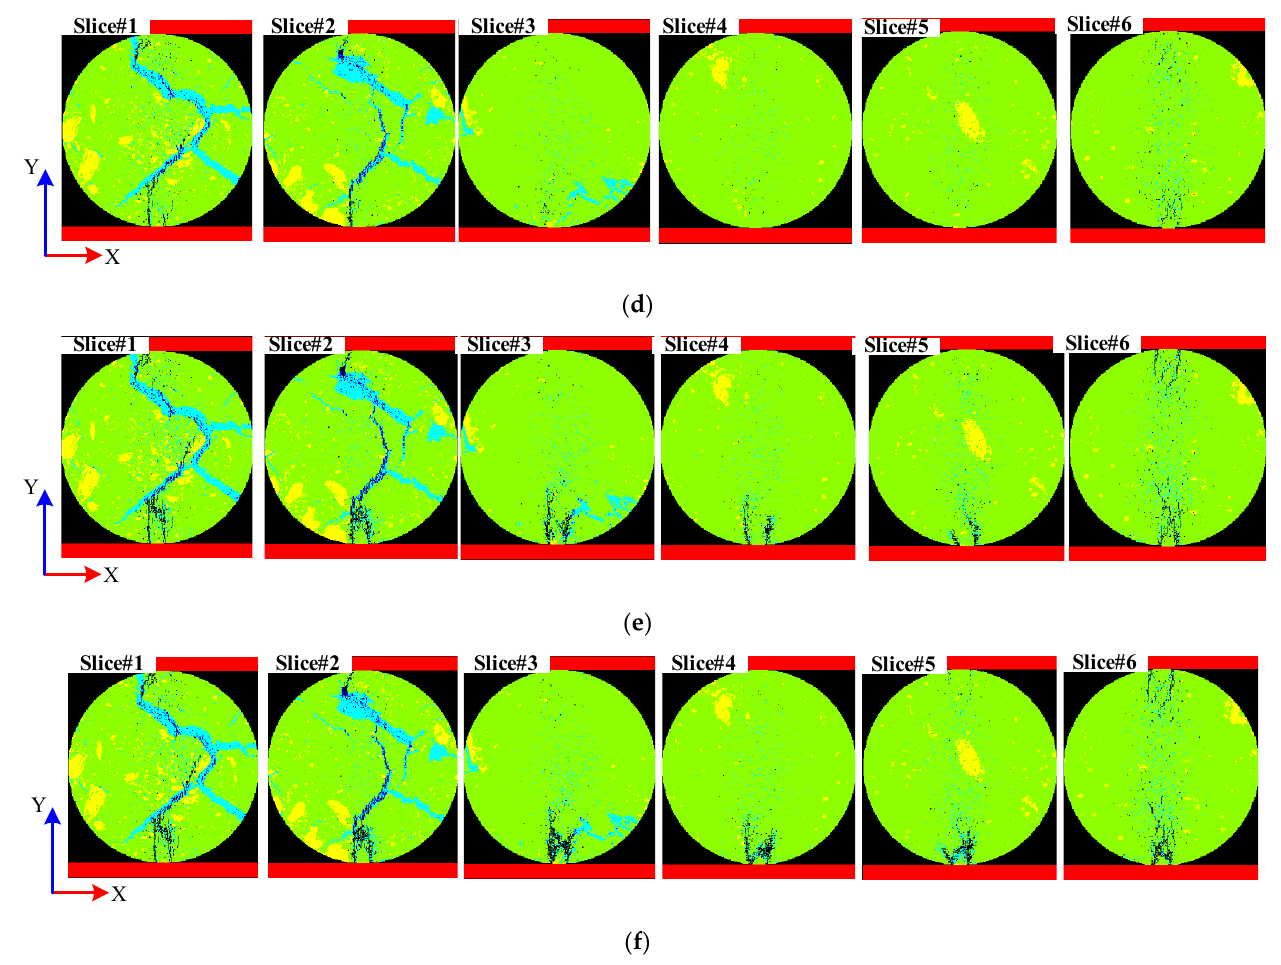
Figure 11. Internal fracture evolution in a shale meso sample sliced along different Z planes. ( a – f ) The slices are at different loading stages, corresponding to points A–F in Figure 10g, respectively. ( organic matter, clay minerals, carbonate minerals, damage elements, fractures).